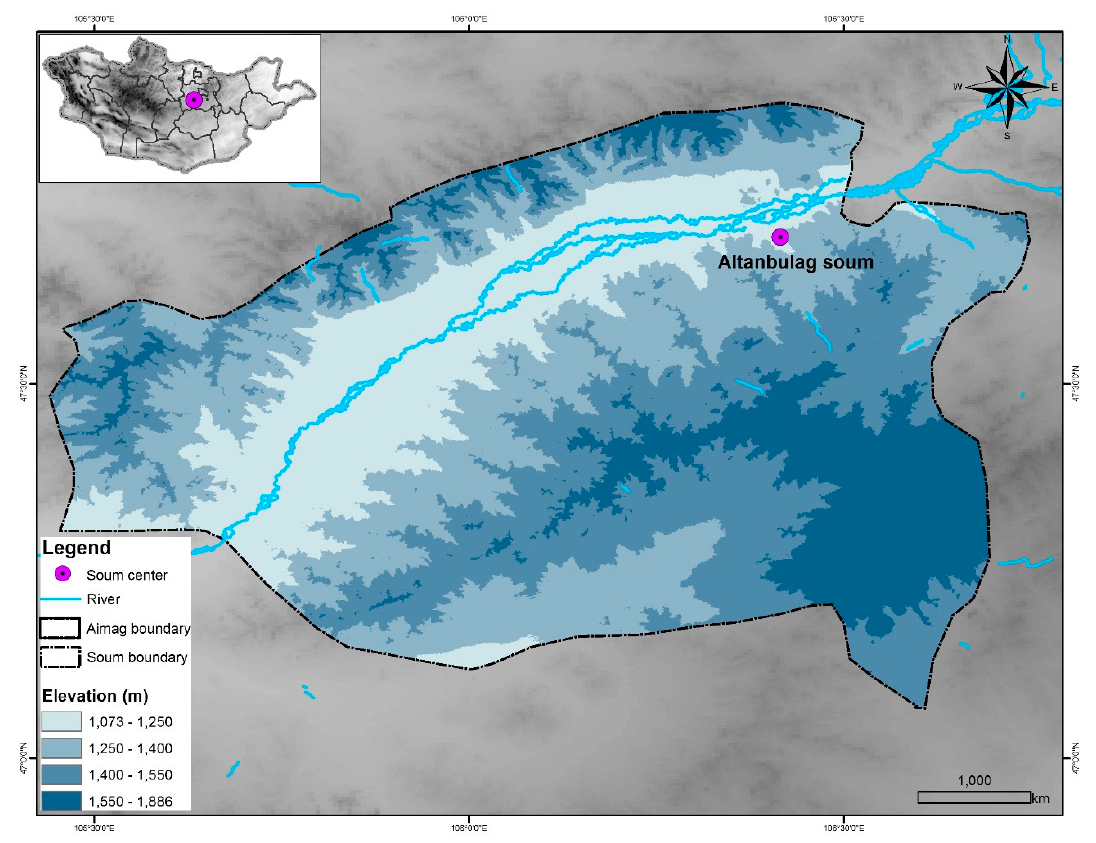
Figure 1. Study area, elevation map of the Altanbulag soum.